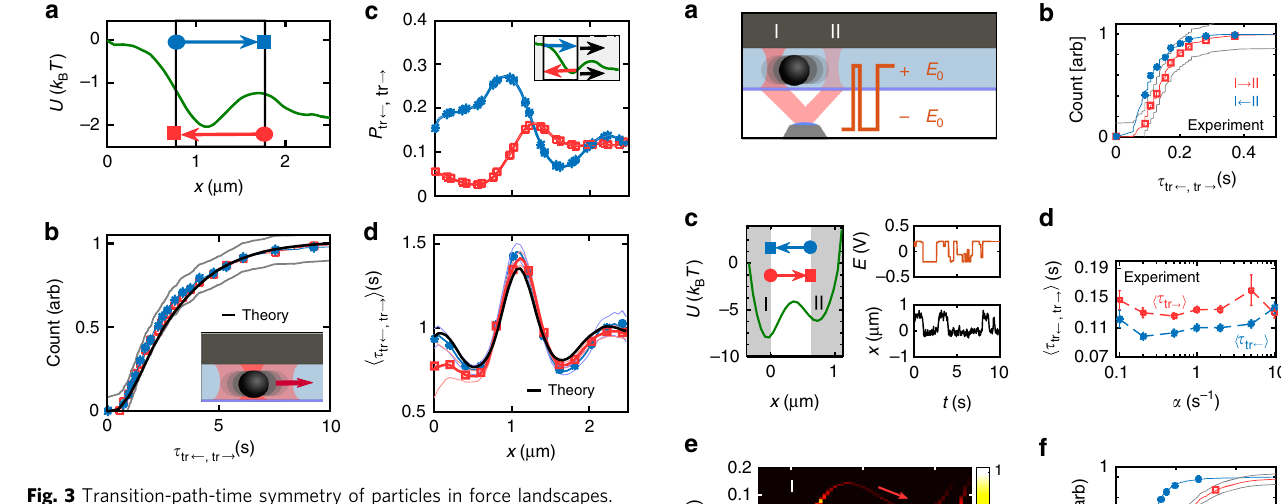
doublet: high ( F + , U + ) and low force ( F − , U − ). This is shown in Fig. 5b using the density P i , j of states in a coarse-grained space spanned by the force measured by the optical tweezers f and the trap position λ . Importantly, as the arrows indicate, the telegraph force not only leads to a splitting of states, but also causes tran- sition pathways to diversify. The system is more likely to unfold F → U during extended periods of high force ( + ), than during periods of low force ( − ). As a consequence, transitions from state U U F − to + through − (red arrows in Fig. 5b, c) are more likely than transitions from state U + to F − through F + (blue arrows in Fig. 5b, c).